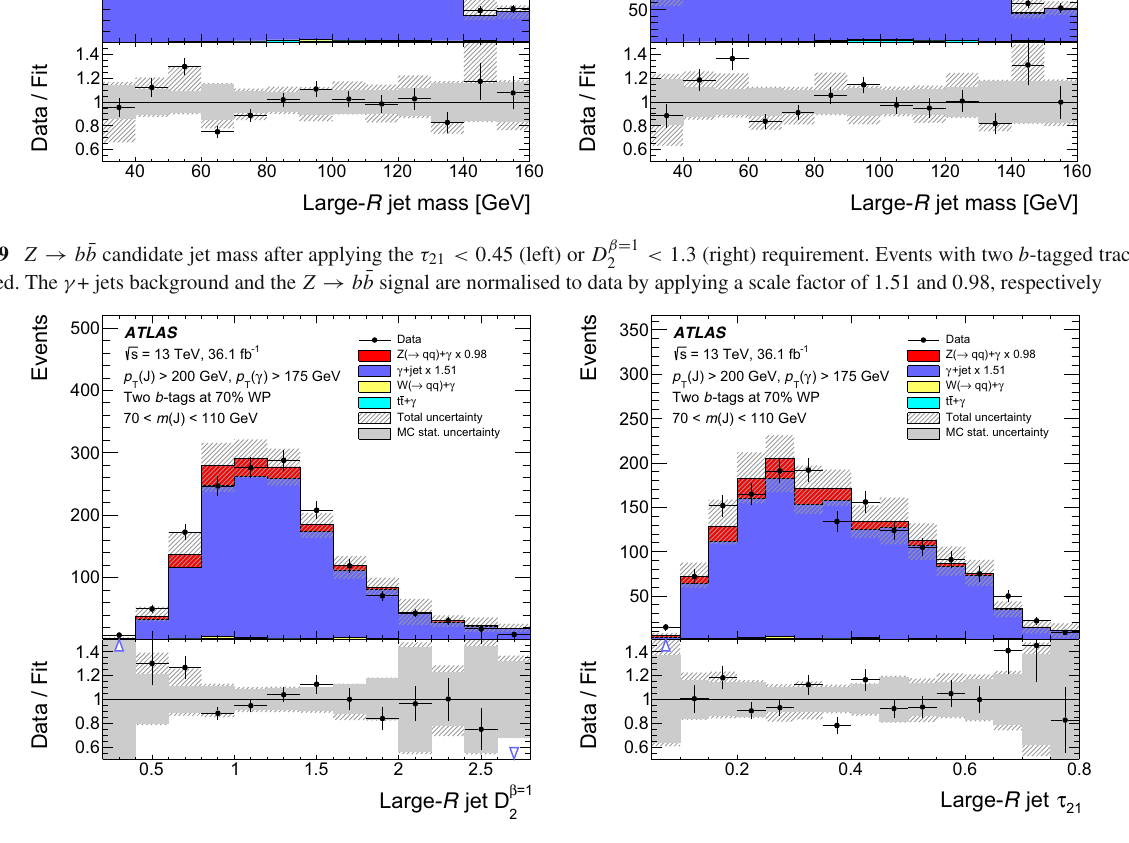
β = 1 Fig. 20 Z → b ¯ b candidate D and τ 21 distributions after requiring 2